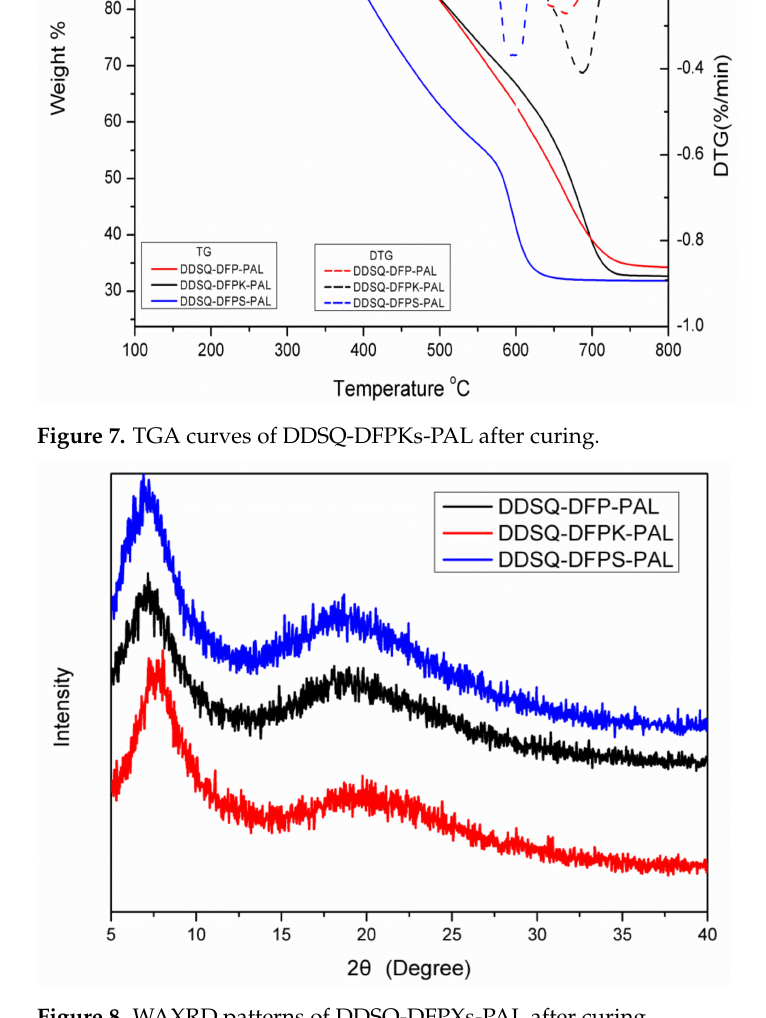
Figure 8. WAXRD patterns of DDSQ-DFPXs-PAL after curing.